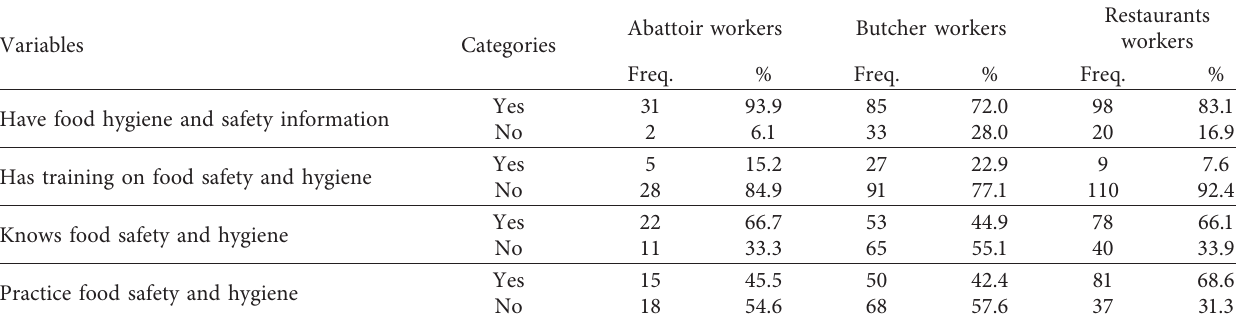
Table 6: Knowledge and practice on food hygiene and food